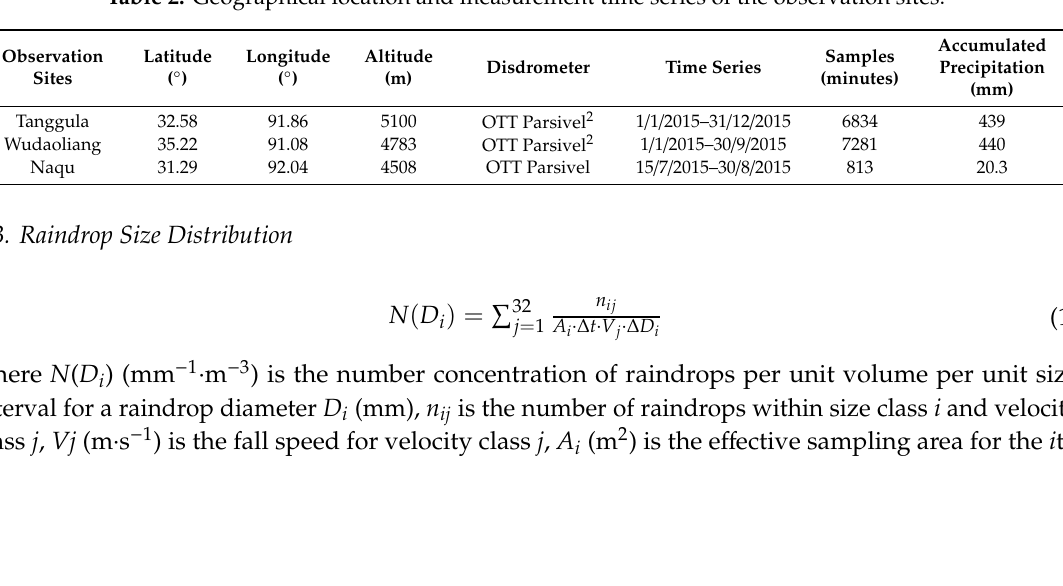
Table 2. Geographical location and measurement time series of the observation